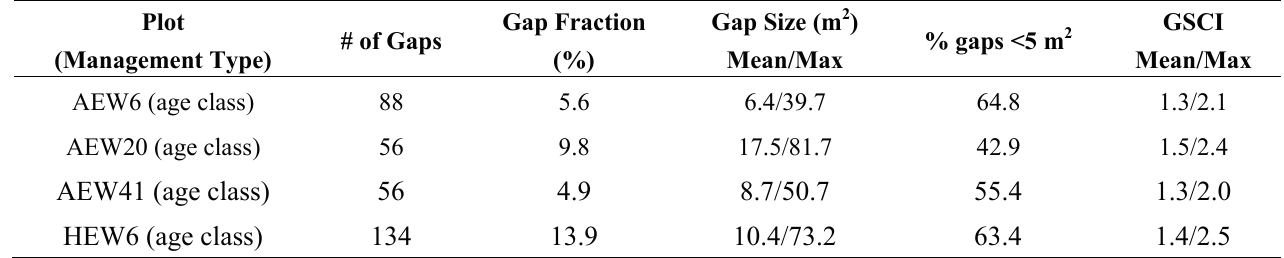
Table 1. Gap structural properties of the 1-ha forest plots. Overview of the most important gap structural properties per 1-ha forest plot (AEW: Schwäbische Alb; HEW: Hainich). The gap fraction is the sum of the area of all gaps in a plot, divided by 100. The GSCI is the gap shape complexity index (GSCI = perimeter/sqrt (4 π area)), whose smallest reference value is 1.0 for describing a circle. A value of, e.g., 2.5 means 150% complexity (see also Getzin et al.